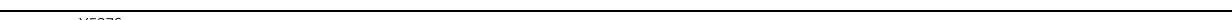
Fig. 2 ESR1 Y537S controls proliferation, EMT, and altered metabolism in SUM44-LTED. a Heatmap depicting the changes in gene expression from four identi fi ed clusters of genes that were signi fi cantly differentially expressed and bound by ESR1 wt (wt-SUM44) or ESR1 Y537S (SUM44-LTED). b Average log2 differences in ESR1 binding for all genes within each cluster during the course of adaptation to LTED. c Pathway analysis of the four clusters using GSEA. Sample labels represent: +E wk0 = wt-SUM44, − E wk1 = 1 wk E-deprived SUM44, − E wk 20 = SUM44-LTED. d Metabolic dependency and capacity of wt- SUM44 and SUM44-LTED on glutamine, fatty acid, and glucose using a Seahorse XFe96 analyzer. ( n = 4 technical replicates). e Comparison of the migratory ability of wt-SUM44 and SUM44-LTED ( n = 8 technical replicates). Error bars represent mean ± SEM. Signi fi cance was assessed by Student ’ s t test. * p < 0.05, ** p < 0.01, *** p <